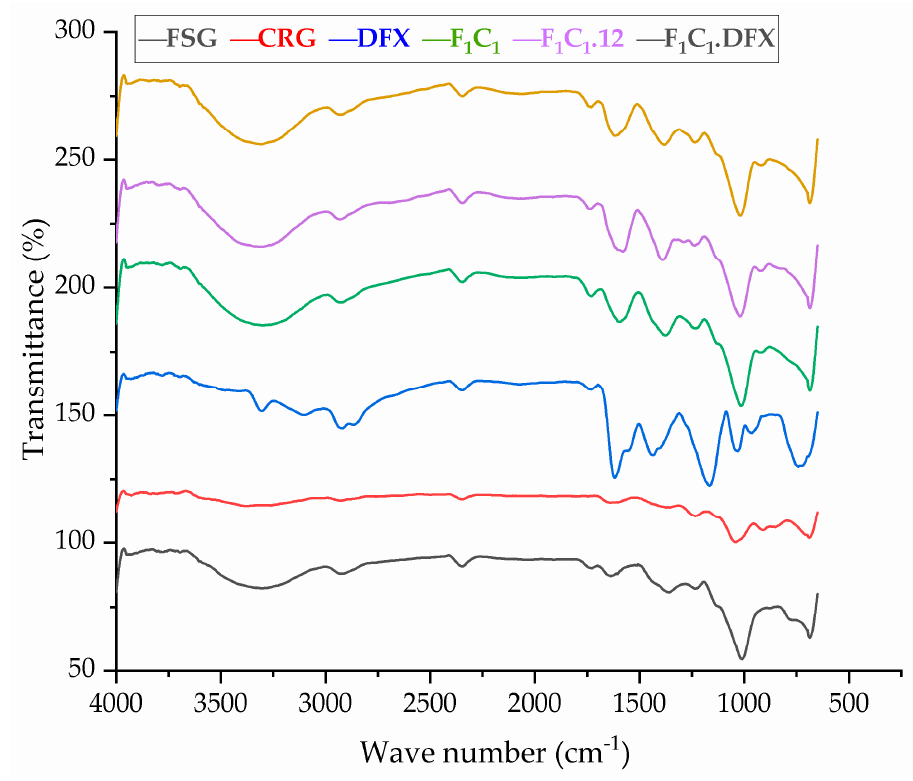
Figure 4. FTIR spectrum of FSG, CGN, pure DFX, F 1 C 1 , F 1 C 1 .12, and F 1 C 1 .DFX.